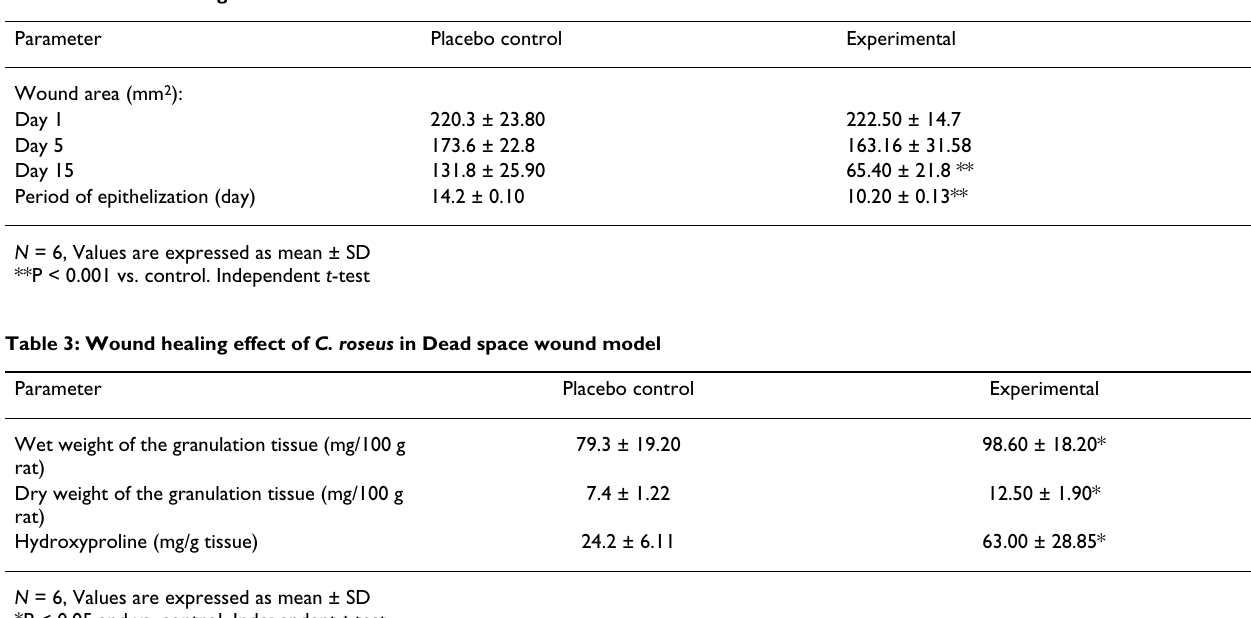
Table 2: Wound healing effect of C. roseus in Excision wound model Parameter Placebo control Experimental